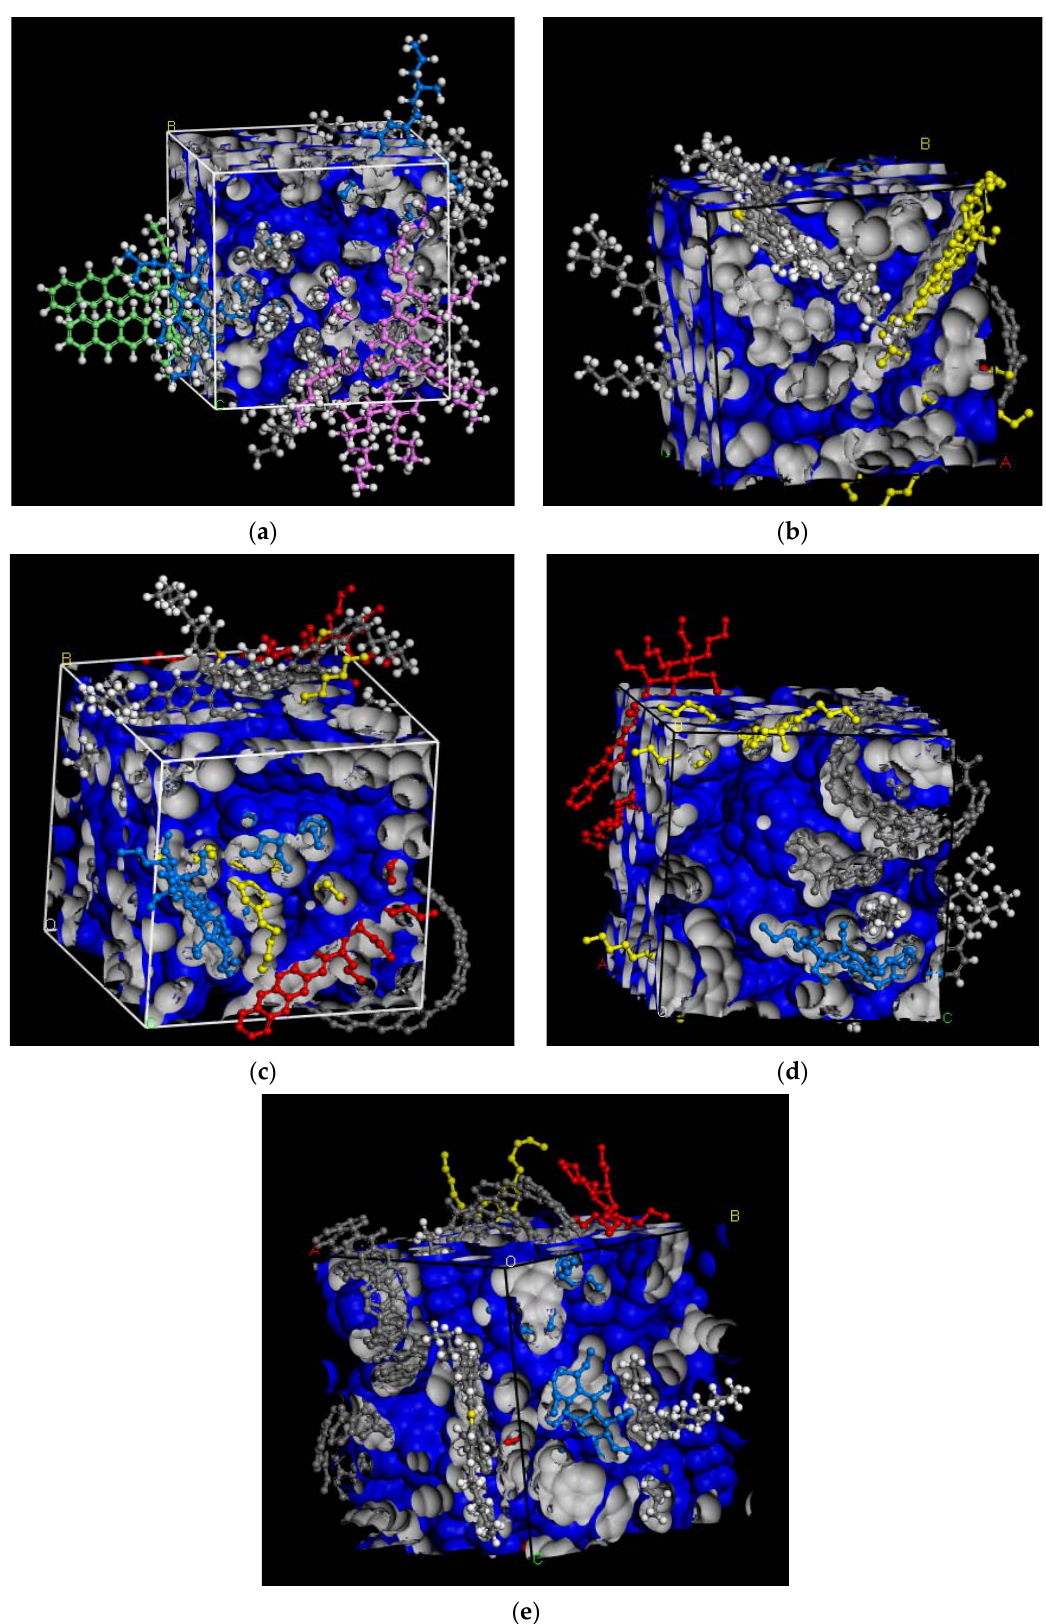
Figure 4. Free volume modeling of the MWCNTs ‐ MA matrix: ( a ) Asphalt ‐ binder; ( b ) 1.0% MWCNTs ‐ MA; ( c ) 1.5% MWCNTs ‐ MA; ( d ) 2.0% MWCNTs ‐ MA; and ( e ) 2.5% MWCNTs ‐ MA.